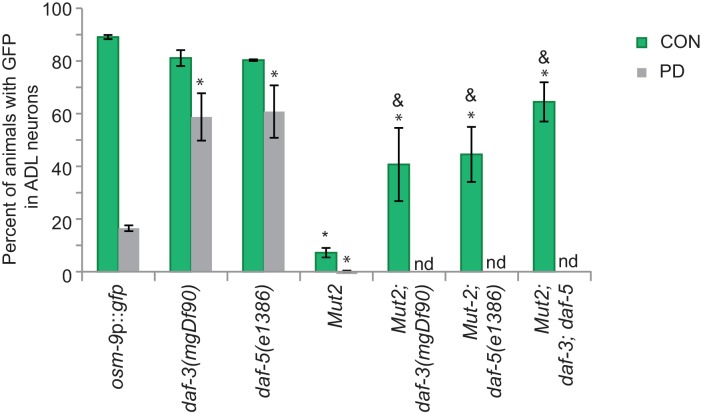
DAF-3 and DAF-5 may also indirectly regulate osm-9 transcription.Our osm-9p::gfp expression and ascr#3 avoidance behavior results both suggested that DAF-3 SMAD and DAF-5 SNO/SKI are acting as a negative regulators of osm-9 in PD ADL neurons (see Figure 3). However, mutation of part of the potential DAF-3 binding site (Mutation 2) resulted in a decrease in osm-9 expression in CON adults. We observed significantly increased GFP expression in ADL neurons of CON adults carrying the Mutation 2 construct in the daf-3(mgDf90), daf-5(e1386), and daf-3(mgDf90); daf-5(e1386) mutant strains compared to wild-type. We were unable to obtain PD adults in these mutant strains to examine GFP levels. DAF-3 has been shown to negatively regulate the genes daf-7, daf-8, and myosin gene myo-2 by binding to their upstream regulatory sequences (Thatcher et al., 1999; Park et al., 2010). Thus, DAF-3 and DAF-5 may be inhibiting activity of an unknown protein that promotes osm-9 expression when they cannot bind to the PD motif. n ≥ 20 animals over at least 3 biologically independent trials. osm-9p::gfp data in wild-type, daf-3(mgDf90), and daf-5(e1386) and Mutation 2 reproduced from Figures 2C and 3A for reference. Data for strains carrying Mutation 2 are averages of values for two independent extrachromosomal lines. * Significantly different from wild-type, & significantly different from Mutation 2, One-way ANOVA, LSD posthoc correction, p<0.05. Error bars represent S.E.M. (Figure 3—figure supplement 1—source data 1).DOI:
http://dx.doi.org/10.7554/eLife.11642.02010.7554/eLife.11642.021Figure 3—figure supplement 1—source data 1.Spreadsheet containing the percentage of animals expressing Mut2 version of osm-9p::gfp in daf-3(mgDf90) and daf-5(e1386) strains.